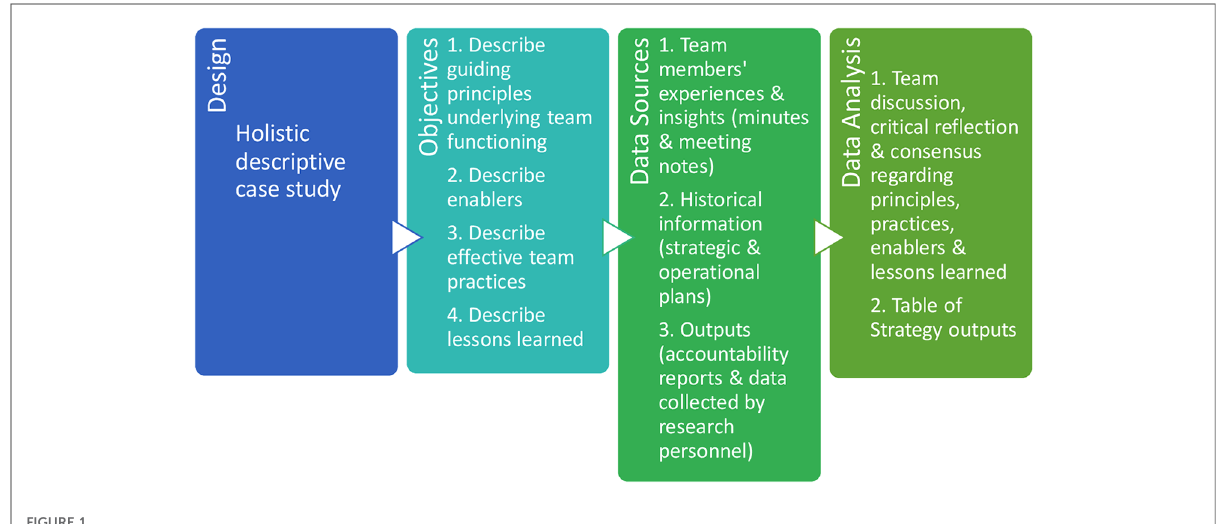
FIGURE 1 Case study